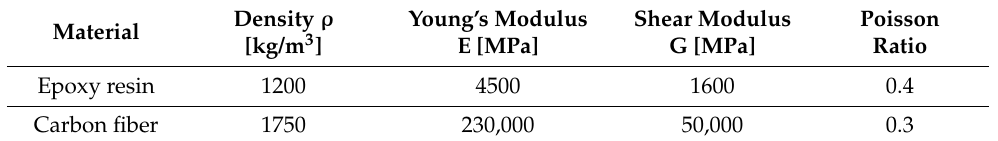
Table 1. Mechanical properties of composite material.